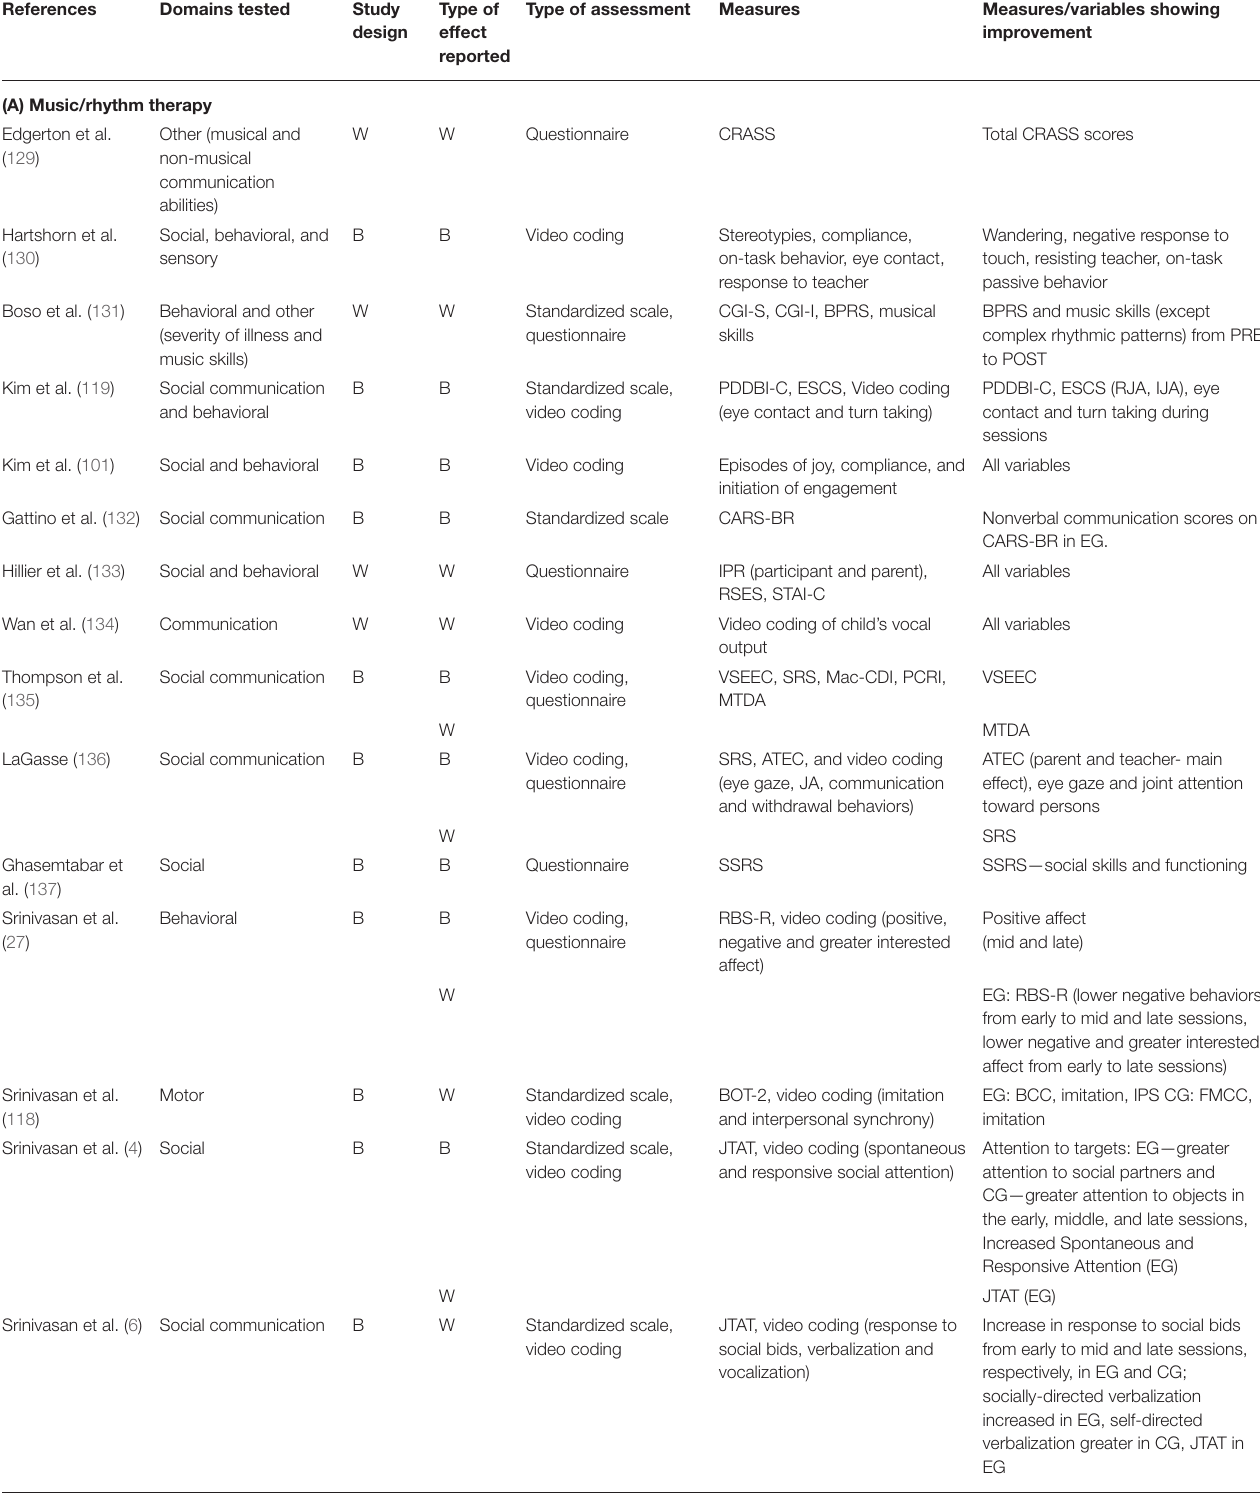
TABLE 3 | Study-wise dependent variables and